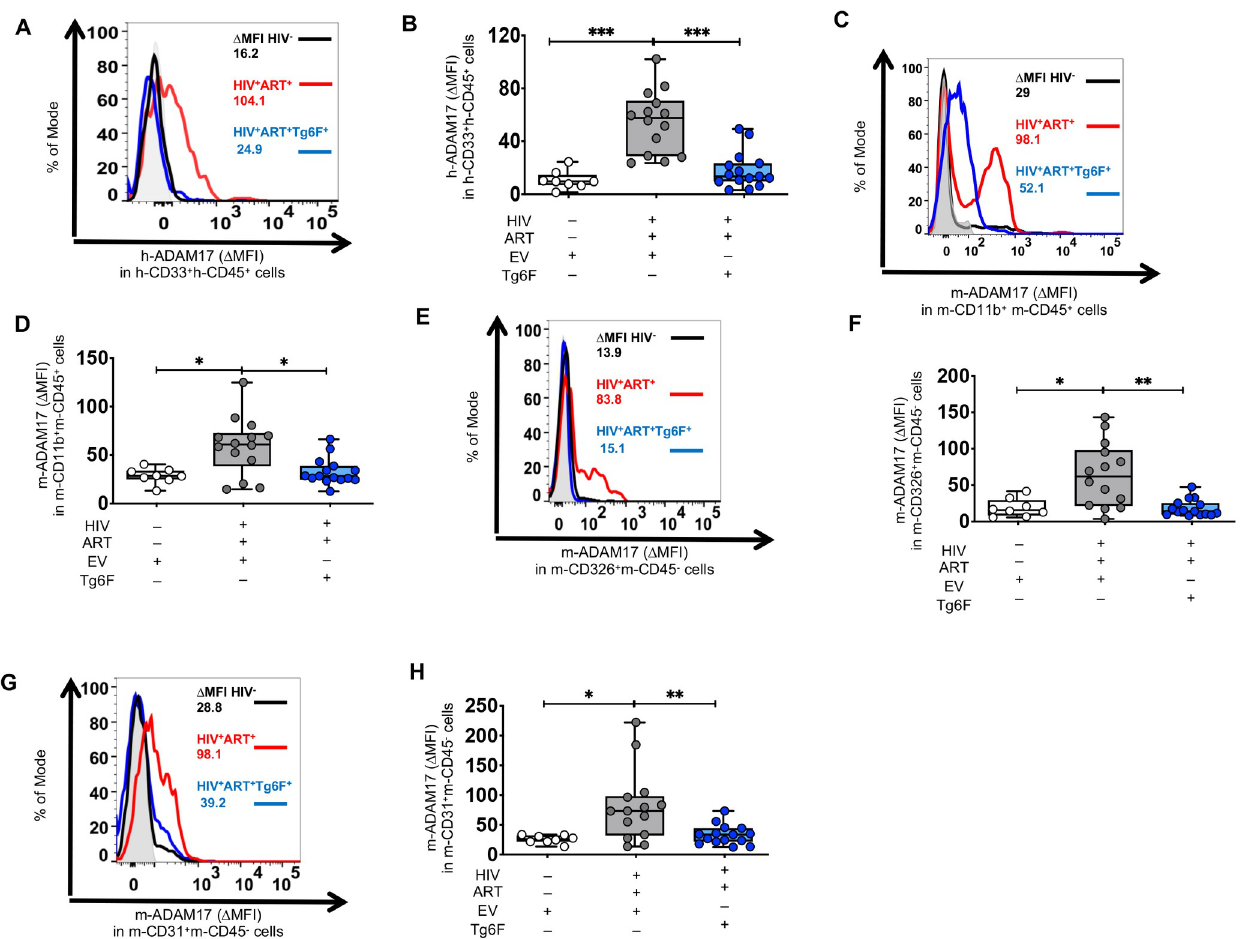
Fig 3. Tg6F attenuates increases in protein levels of ADAM17 in intestinal cells of humanized mice with treated HIV infection. TKO C57 (n = 45) humanized mice were constructed, infected with HIV and treated with antiretroviral therapy (ART) and control transgenic tomato concentrate and/or oral ApoA-I mimetic peptide 6F in the form of transgenic tomato (Tg6F). Single cell suspension from gut was prepared and cellular protein levels of ADAM17 were determined by flow cytometry in intestinal cells. A. Representative data of change in membrane protein expression of human ADAM17 in human h- CD33 + h-CD45 + viable single myeloid immune cells are shown. Δ MFI represents a shift in median fluorescence intensity of a positive cell population compared to a negative cell population within each sample. The negative cell population was defined based on a fluorescence minus one negative control for staining as shown in light filled grey histogram). B. Summary of data for (A). C. Representative data of Δ MFI of murine ADAM17 in murine CD11b + CD45 + myeloid immune cells are shown . D. Summary of data for ( C ). E. Representative data of Δ MFI of murine ADAM17 in murine CD326 + CD45 - epithelial cells are shown . F. Summary of data for ( E ). G. Representative data of Δ MFI of murine ADAM17 in murine CD31 + CD45 - endothelial cells are shown . H. Summary of data for ( G ). Data represent box and whiskers with minimum, median and maximum values ( n = 8–22 mice per group). Datapoints represent mean of at least 2 experimental replicates per mouse. The Kruskal Wallis was used to compared > 2 groups and the Mann-Whitney test was used to compare 2 groups ( � p < 0.05, �� p < 0.01, ��� p <